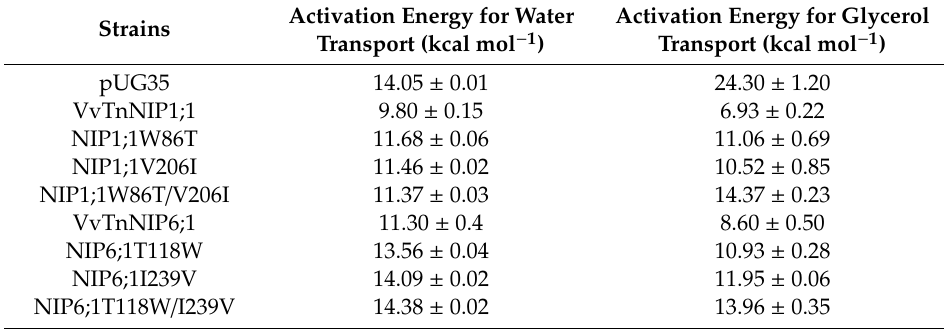
Table 1. Activation energy ( Ea ) for water and glycerol transport of native VvTnNIP1;1 and VvTnNIP6;1, and their ar / R filter mutant variants. Activation Energy for Water Transport Activation Energy for Glycerol Transport Strains (kcal mol −1 ) (kcal mol −1 ) pUG35 14.05 ± 0.01